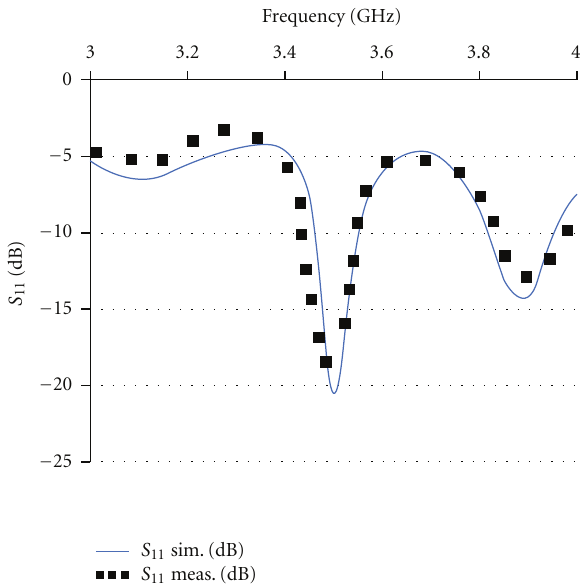
Figure 6: S 11 parameter for backhaul antenna.